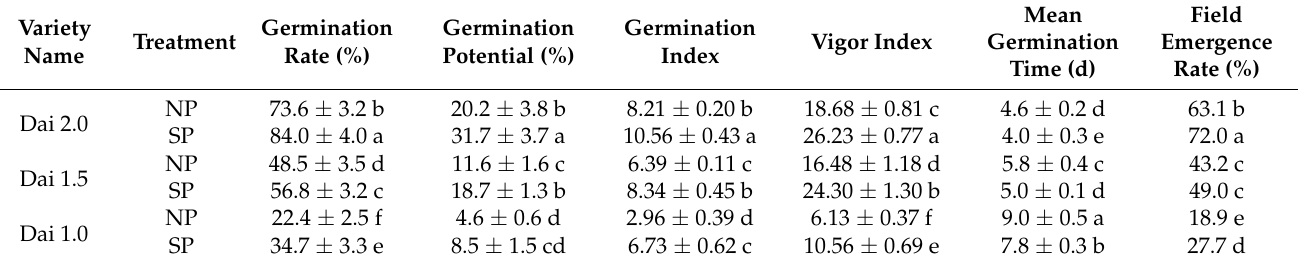
Table 2. Effect of sand priming on seed germination of Pinus massoniana Lamb.